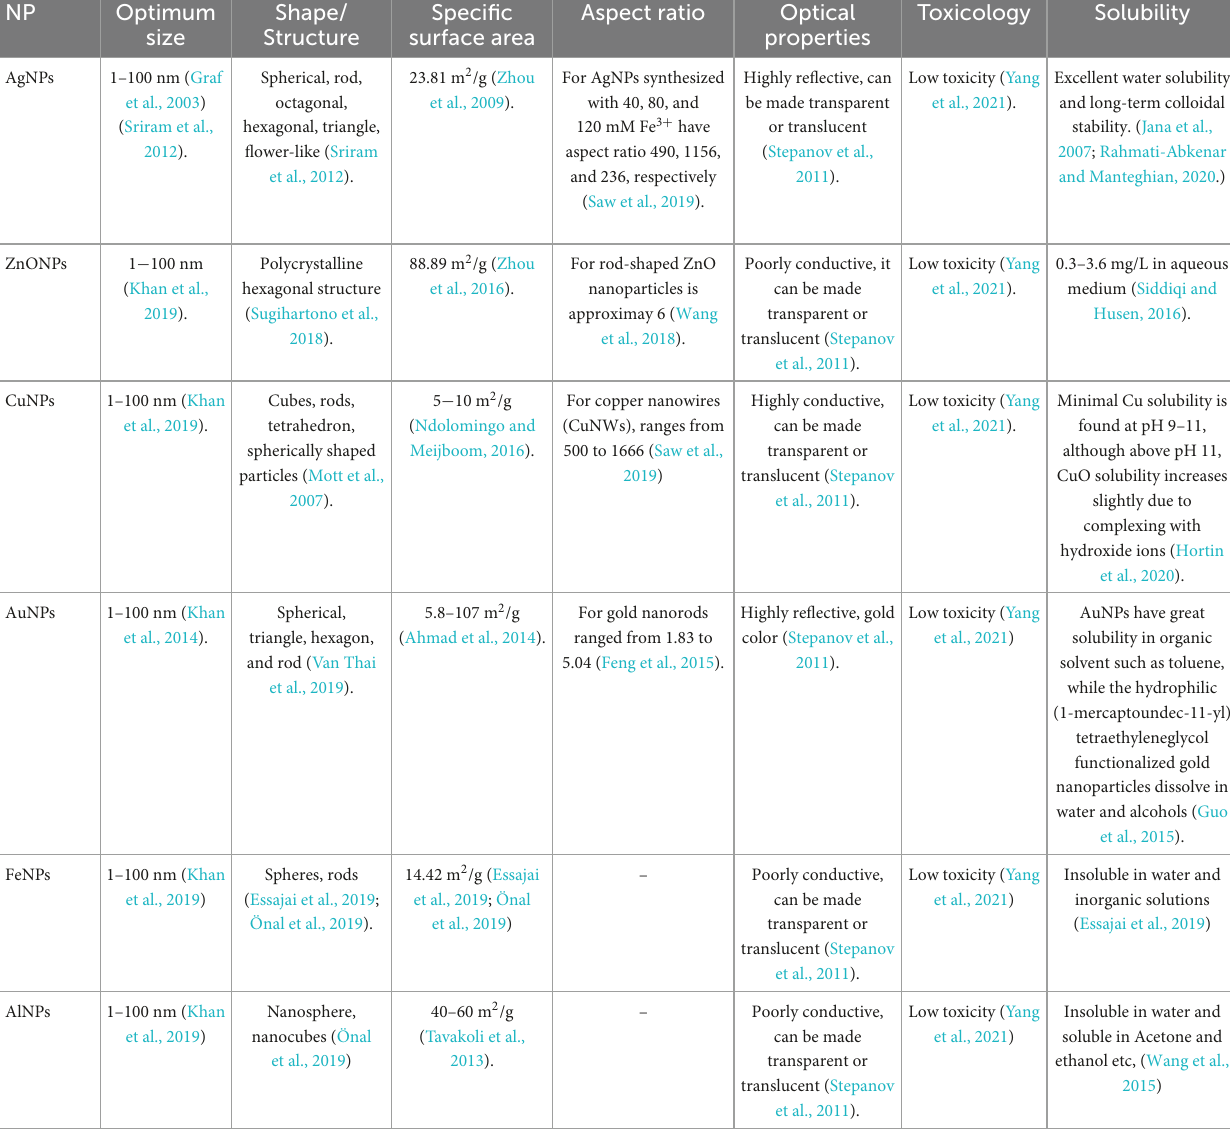
TABLE 1 Characteristics of metal based